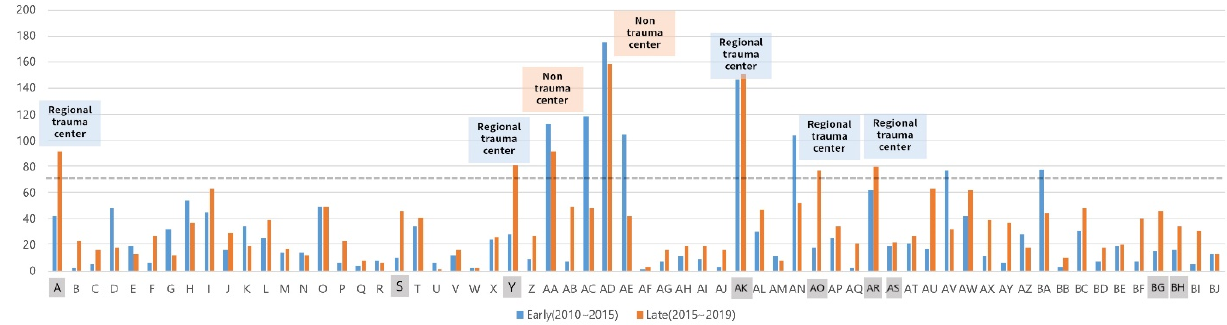
Figure 1. Comparison of recruitment numbers of deceased donors from regional trauma and non- trauma centers.